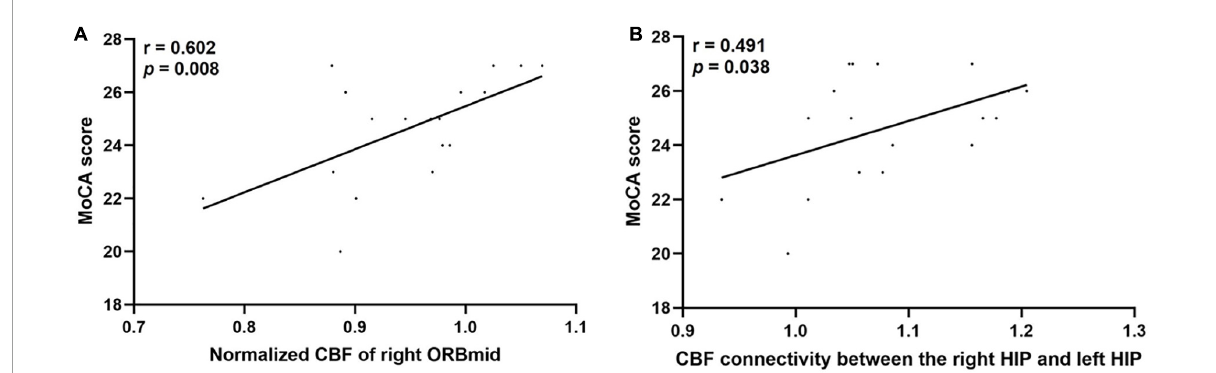
FIGURE5 The statistically significant correlations between the normalized CBF and CBF connectivity changes and the MoCA score only in men patients. Spearman correlation analysis and Bonferroni correction for multiple comparisons were performed. P < 0.05 was considered statistically significant. (A) The MoCA score was positively correlated with the normalized CBF of the right ORBmid in men patients ( r = 0.602, P < 0.05), N for Bonferroni corrections = 12; (B) The MoCA score was positively correlated with the CBF connectivity between the right HIP and the left HIP in men patients ( r = 0.491, P < 0.05), N for Bonferroni corrections = 12. CBF, cerebral blood flow; MoCA, montreal cognitive assessment; ORBmid, middle frontal gyrus, orbital part; HIP,